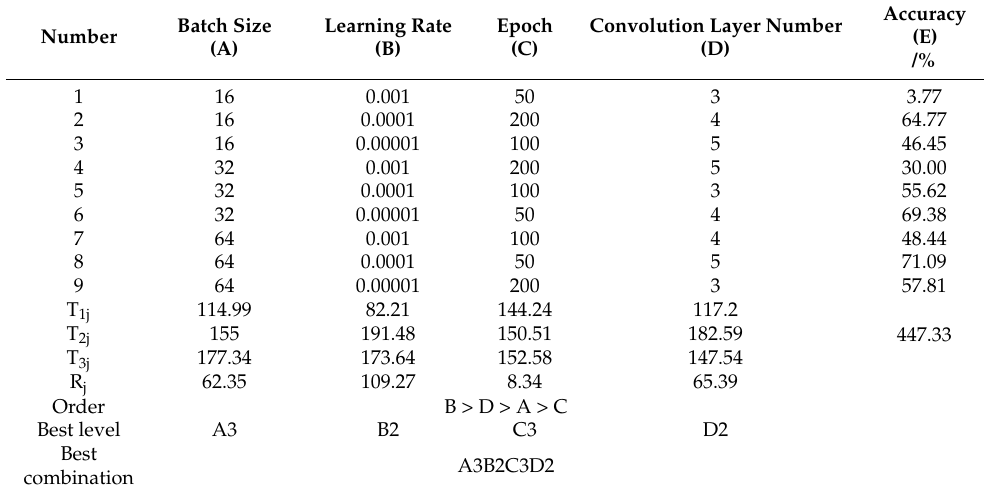
Table 2. The first orthogonal experiment.